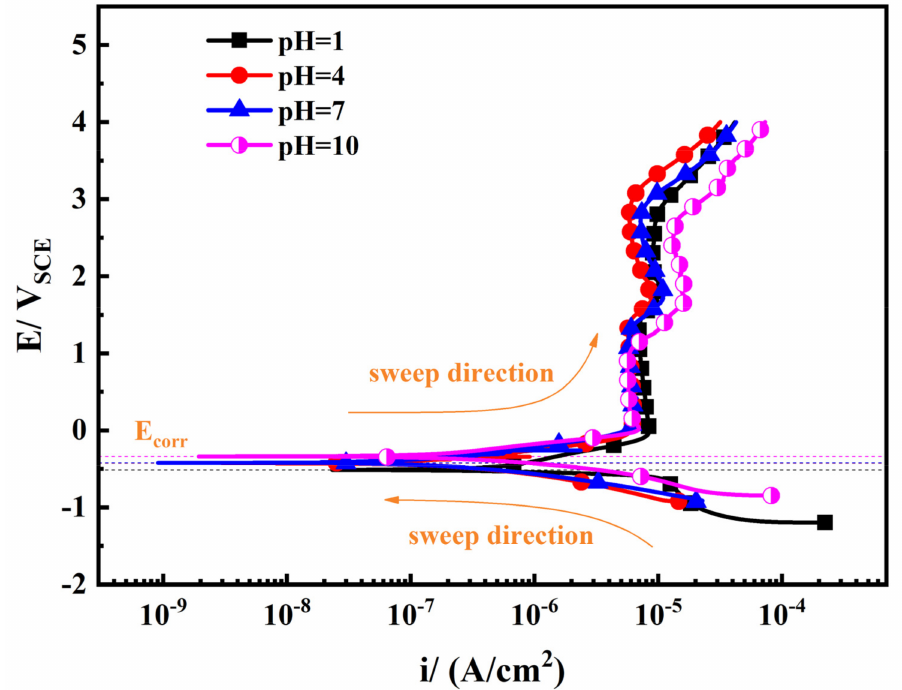
Figure 1. Potentiodynamic polarization curves of TA2 in simulated seawater with different pH